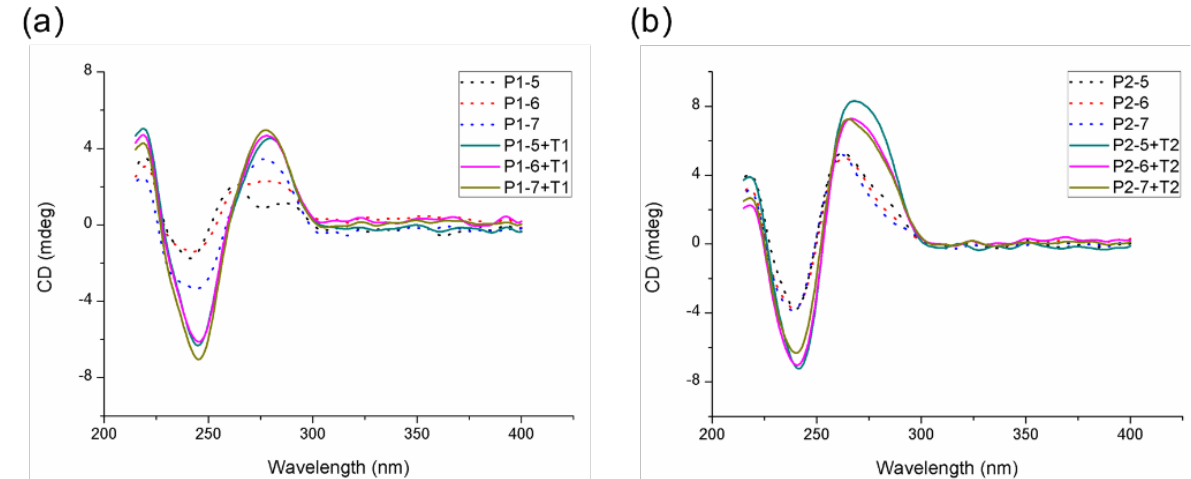
Figure 2. CD spectra of the designed probes ( a ) P1 and ( b ) P2 with different stem lengths (5, 6 and 7 bp) in the absence and presence of the corresponding targets T1 and T2, respectively. Conditions: 2 µ M for each of the probes or targets, 20 mM MgCl 2 , 100 mM NH 4 Cl, and 100 mM Tris-HCl (pH 7.4).